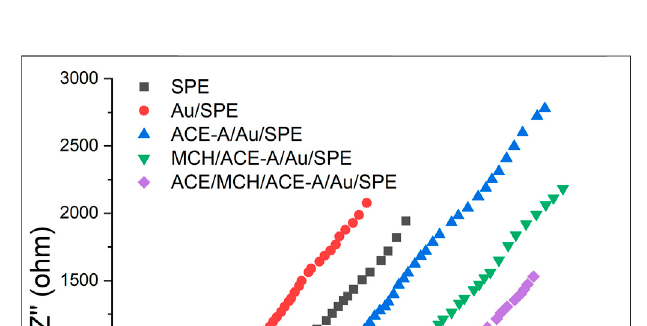
FIGURE 2 | SEM images of SPE and Au/SPE.